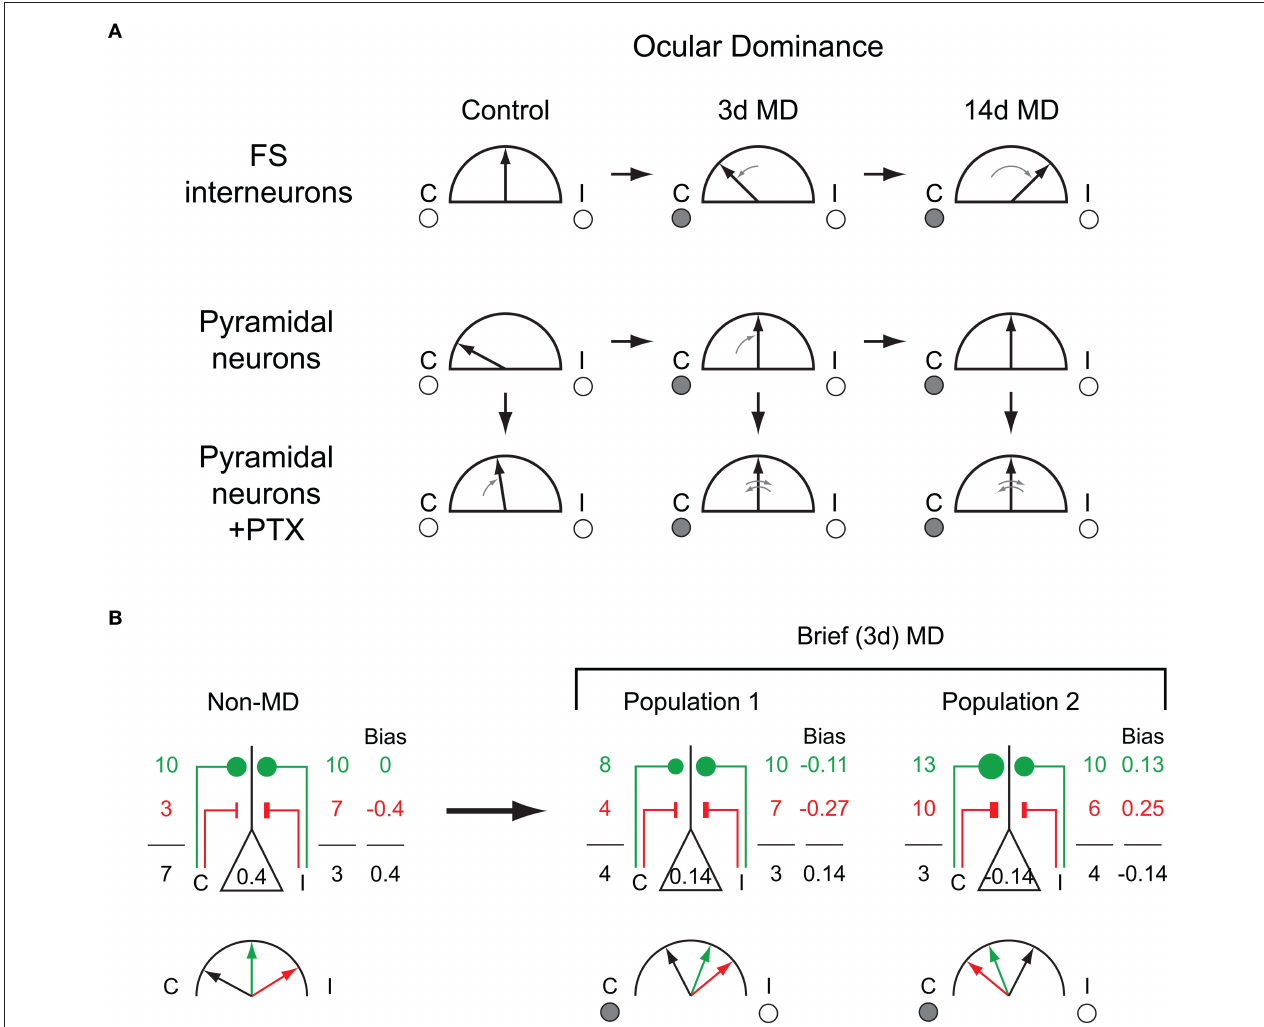
and inhibitory inputs which could potentially produce the observed data. Numbers represent relative excitatory (green) and inhibitory (red)